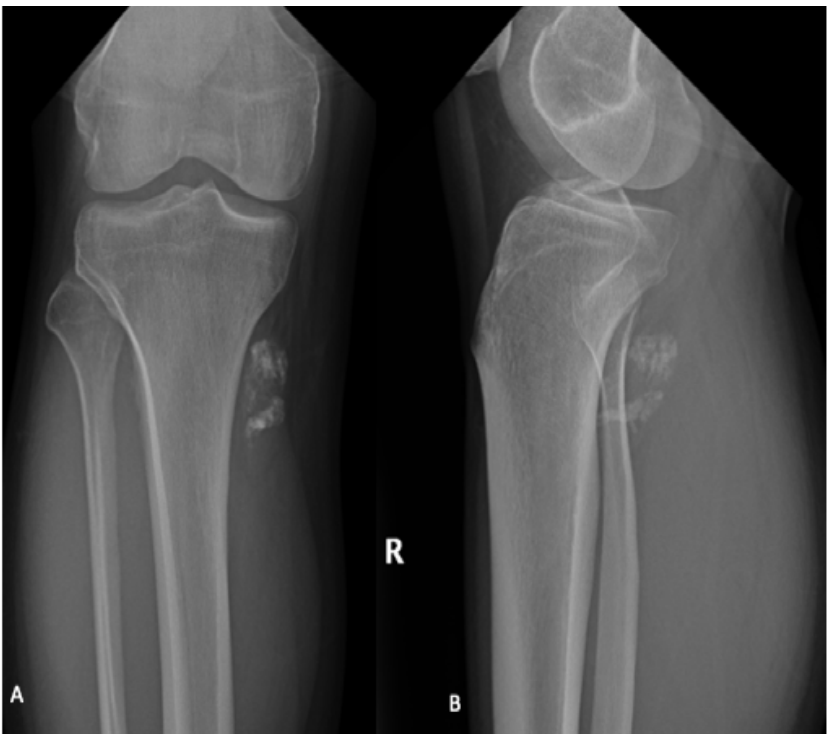
Figure 1. AP ( A ) and lateral ( B ) radiographs of the right (R) knee and lower leg in a 31-year-old male demonstrate coarse calcifications within the soft tissues adjacent to the posteromedial tibial plateau, corresponding to a biopsy proven synovial sarcoma. No significant articular abnormality. Adjacent bony structures appear unremarkable.